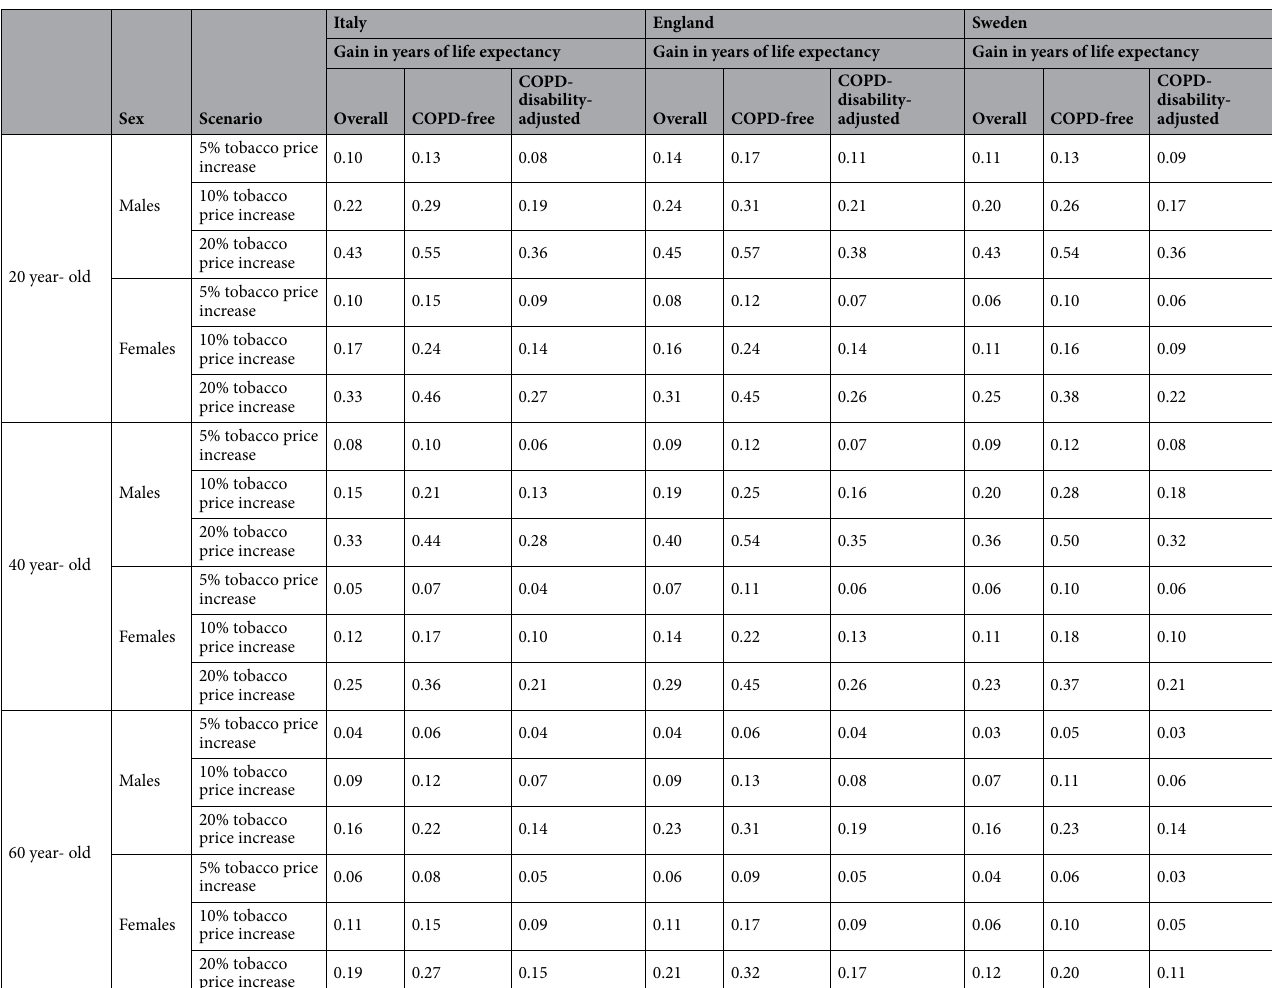
Table 3. Absolute gain in overall, COPD -free, and COPD-disability-adjusted cohort life-expectancy (expressed in years) of a 20, 40 and 60 year-old male and female at baseline (2018), as compared to the reference scenario. Results reported per country and intervention